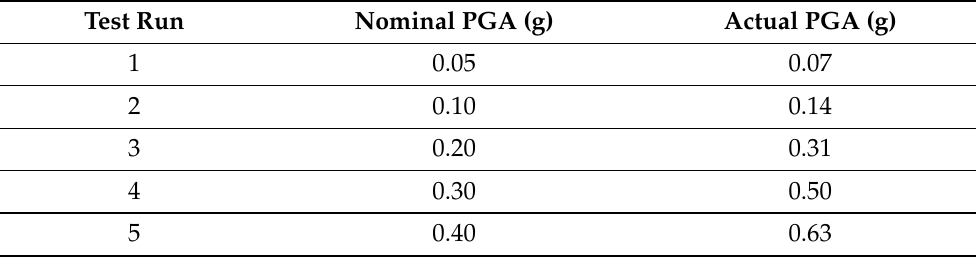
Table 3. Building 1: Summary of shake-table runs